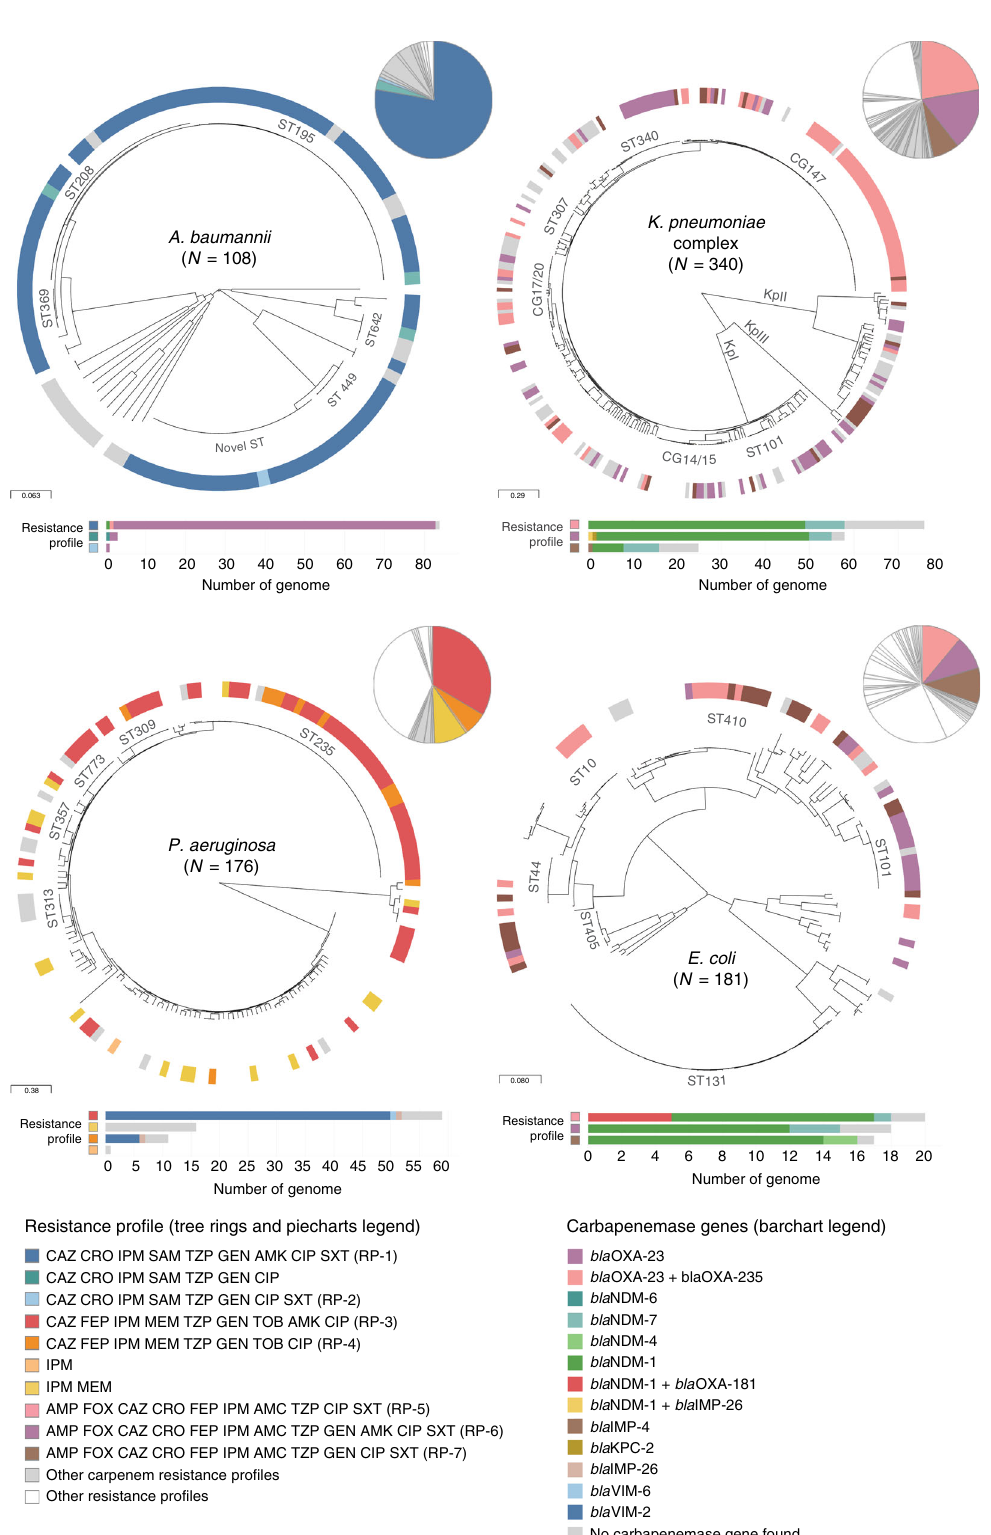
Fig. 3 Carbapenem resistance pro fi les are not associated with speci fi c genetic lineages. Phylogenetic trees showing the major lineages of A. baumannii , P. aeruginosa , K. pneumoniae species complex and E. coli , indicating the position of select sequence types (ST) and clonal groups (CG). KpI K. pneumoniae sensu stricto, KpII K. quasipneumoniae , KpIII K. variicola . Tree ring: select carbapenem resistance pro fi les from Fig. 2 are shown in colour. The remaining carbapenem resistance pro fi les are shown in light grey. Other resistance pro fi les (susceptible to carbapenems) are shown in white for simplicity. The three- letter antibiotic codes are as in Table 1. The pie charts show the relative abundance of the resistance pro fi les in the retrospective collection of sequenced genomes. The bar charts show the distribution of carbapenemase genes across the key resistance pro fi les. The scale bars show the number of SNPs per variable site. The data are available at https://microreact.org/project/ARSP_ABA_2013-14 (Aba), https://microreact.org/project/ARSP_PAE_2013-14 (Pae), https://microreact.org/project/ARSP_KPN_2013-14 (Kpn) and https://microreact.org/project/ARSP_ECO_2013-14